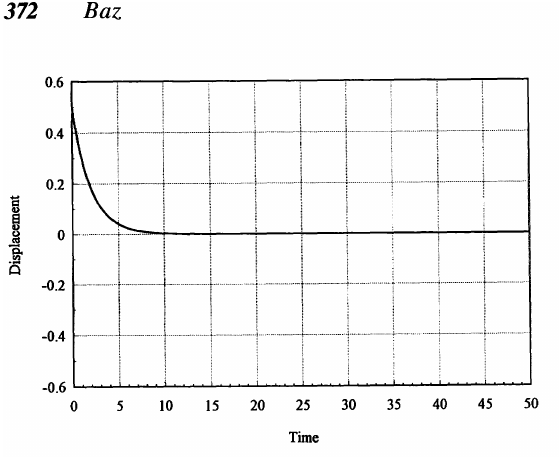
FIGURE 8 Time response of y of the controlled prism with 50% uncertainty in natural frequency, y(O) = 0.5,